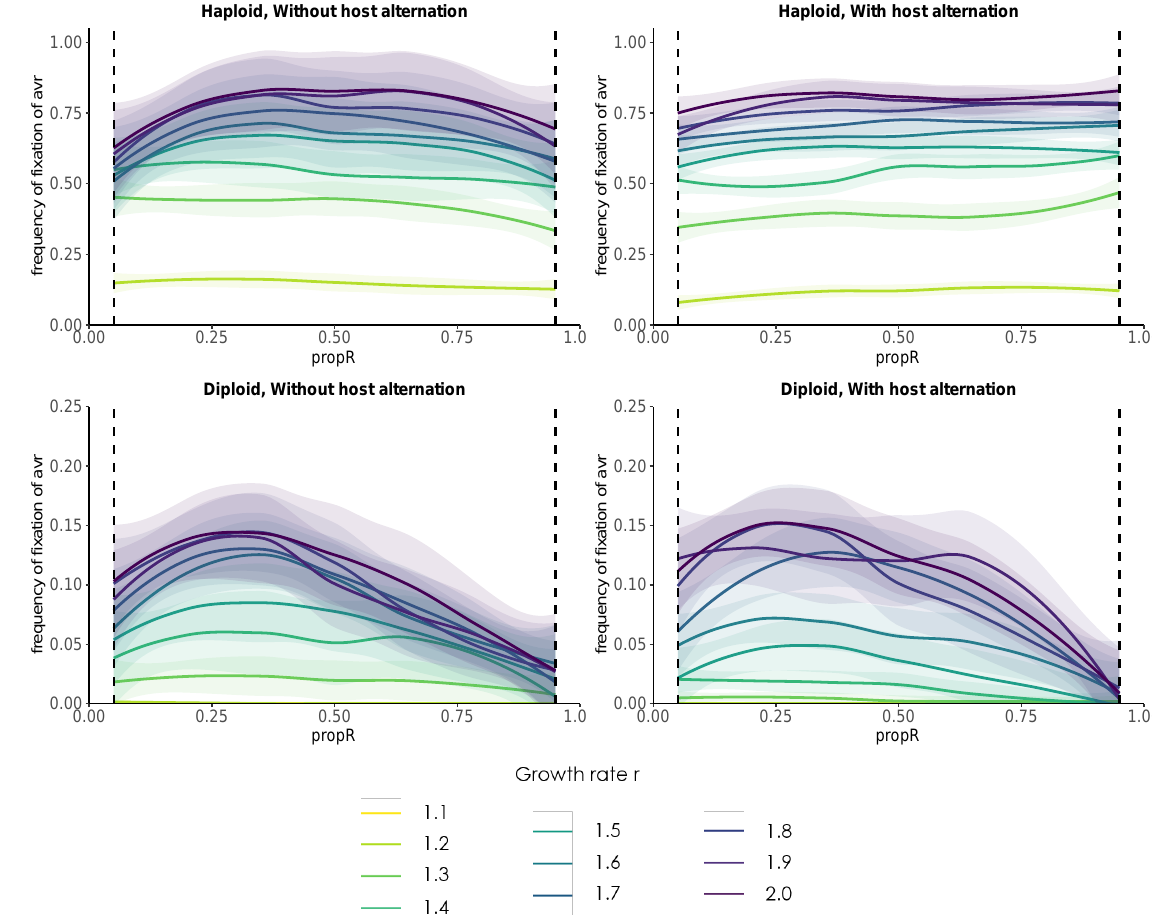
Figure 5 – Evolution of the frequency of fixation of the avr allele depending on propR for r varying between 1.1 and 2.0, with f avr = 0.0005 . Simulations were performed without and with host alternation, for haploid and diploid individuals, with 100 replicates for each combination of parameters. The plotted results correspond to the local regression on the frequency of fixation of the avr allele with the 95% confidence intervals associated with each regression. The vertical dotted lines correspond to the bounds of simulated values of propR for this regular experimental